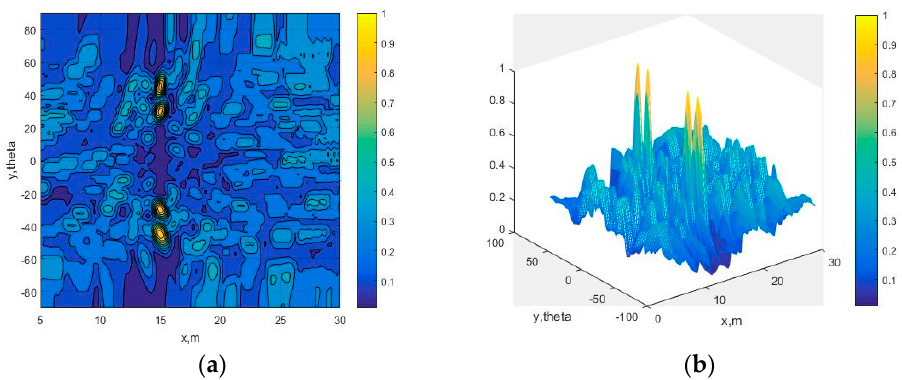
Figure 6. Focusing position. ( a ) Total field diagram for four-point sequential focus; ( b ) perspective view of four-point sequential focus.